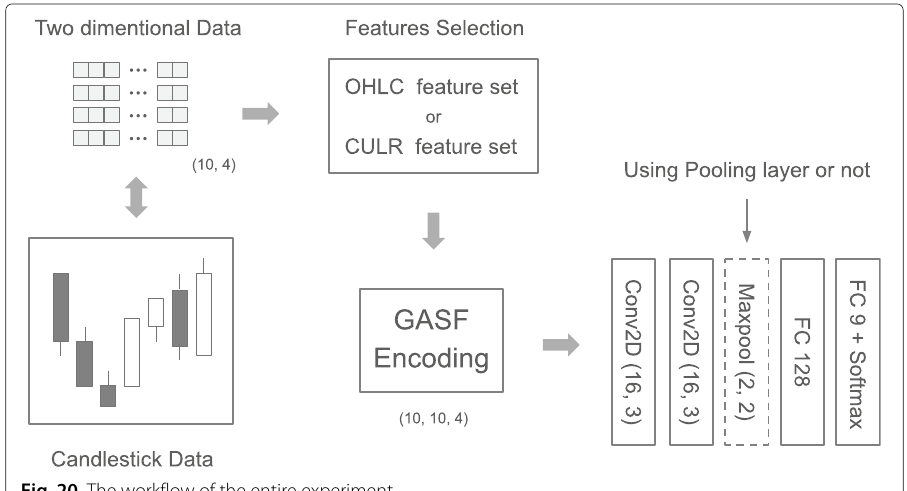
Fig. 20 The workflow of the entire